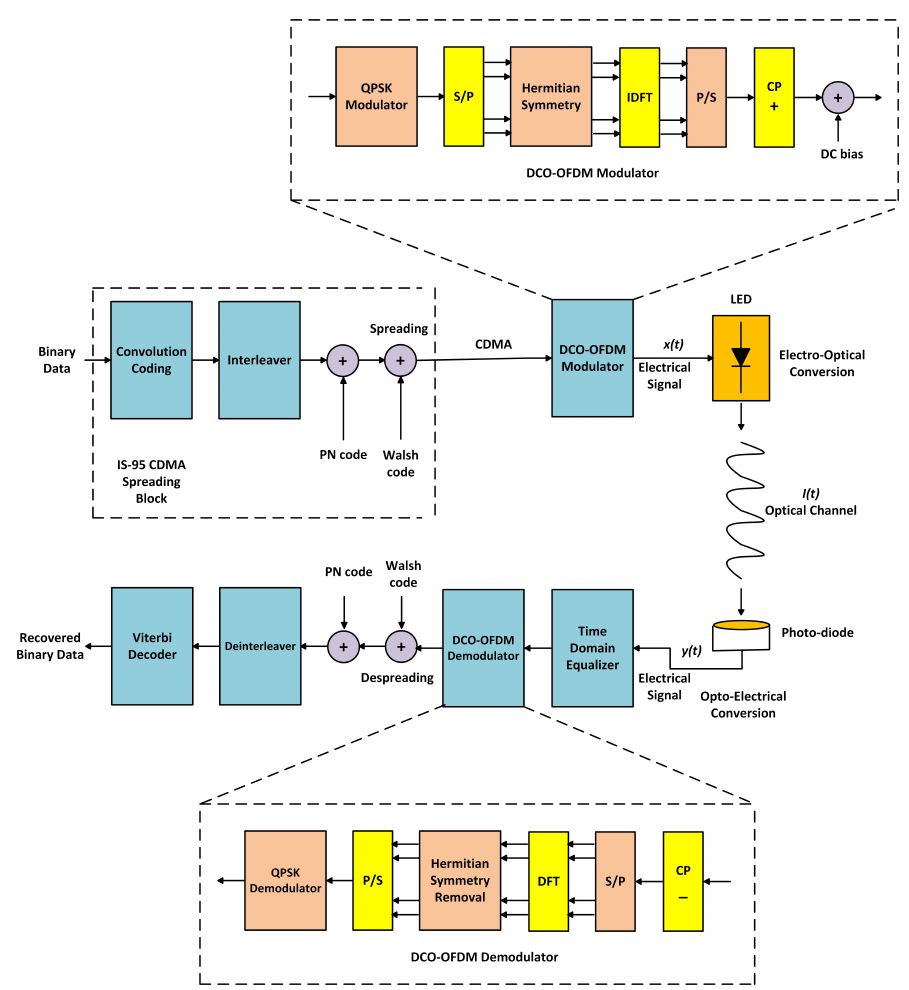
Figure 1. Generic block diagram of DFT-based MC-CDMA